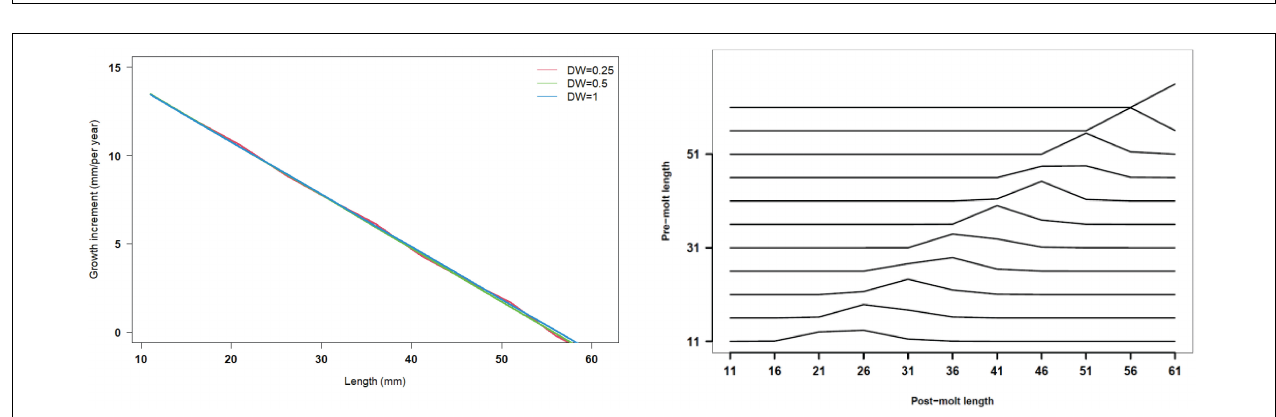
FIGURE 8 | Survey selectivity and fishing selectivity in 1992–2011 years (red line present weights in 0.25, green line present weight in 0.5, blue line present weight in 1).